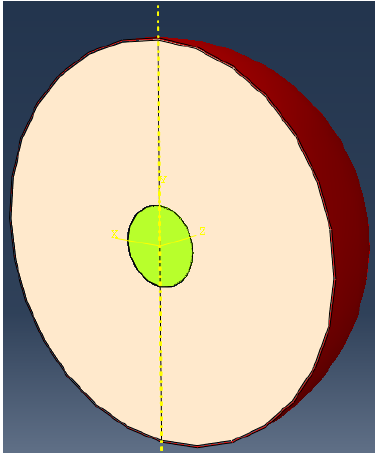
Figure 1. Cross-section view of the FEM model of an apple.